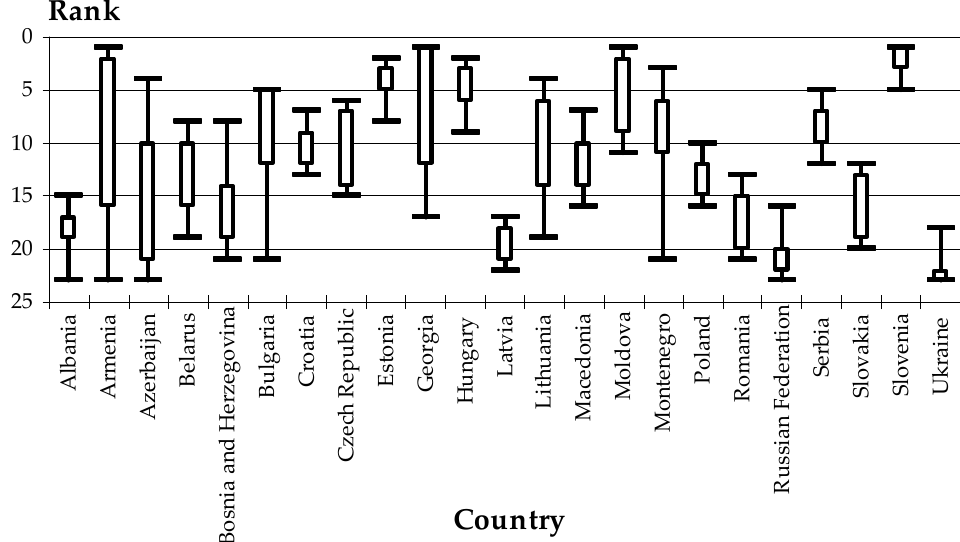
Figure 3. The visibility of articles published on aggregated “engineering” sciences (including decision sciences; computer science; energy; engineering; chemical engineering; materials science) in Eastern European countries during 2010–2018, measured based on the adjusted number of citations per document. The figure displays the ranks of countries computed for each year separately. Results indicate a huge variability and inconsistent patterns for most of the countries analyzed, except for the occupants of top positions, which exhibit steadier dynamics.